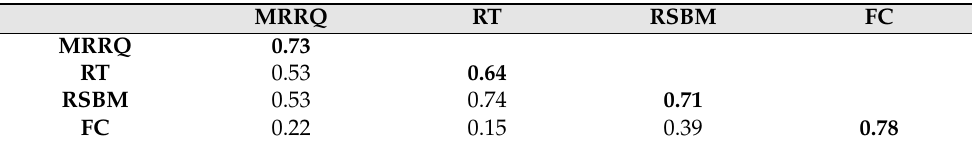
Table 7. Correlation coefficient confidence intervals.